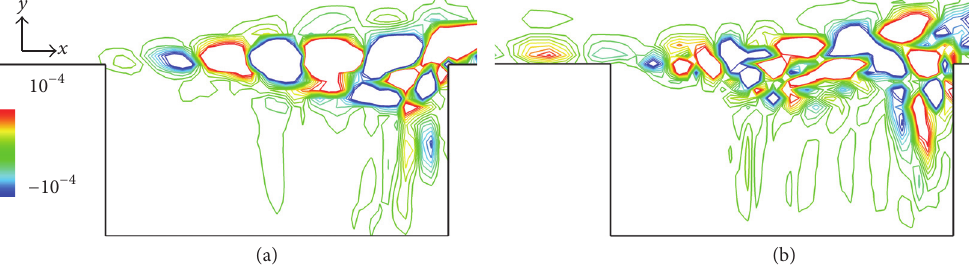
/ 𝜕𝑥 𝑖 𝜕𝑥 𝑗 /( 𝜌 ∞ 𝑈 ∞2 /𝐿 2 ), around cavity ij